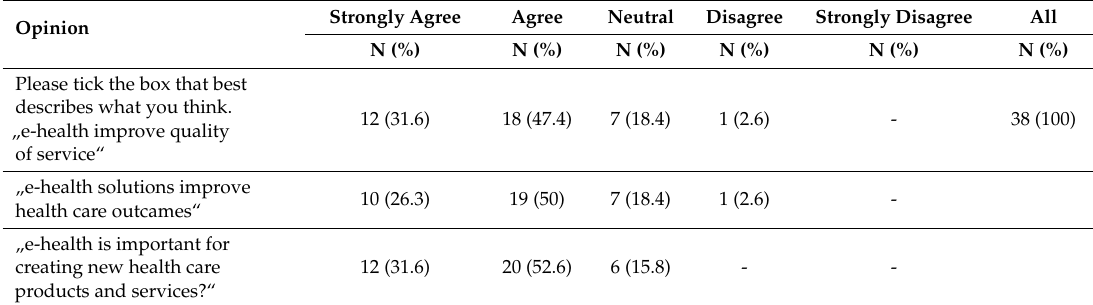
Table 7. Please tick the box that best describes what you think “e-health improve quality of